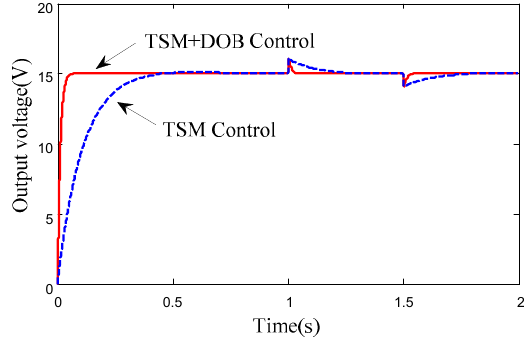
Figure 4. Simulated step-load waveform of the output voltage.